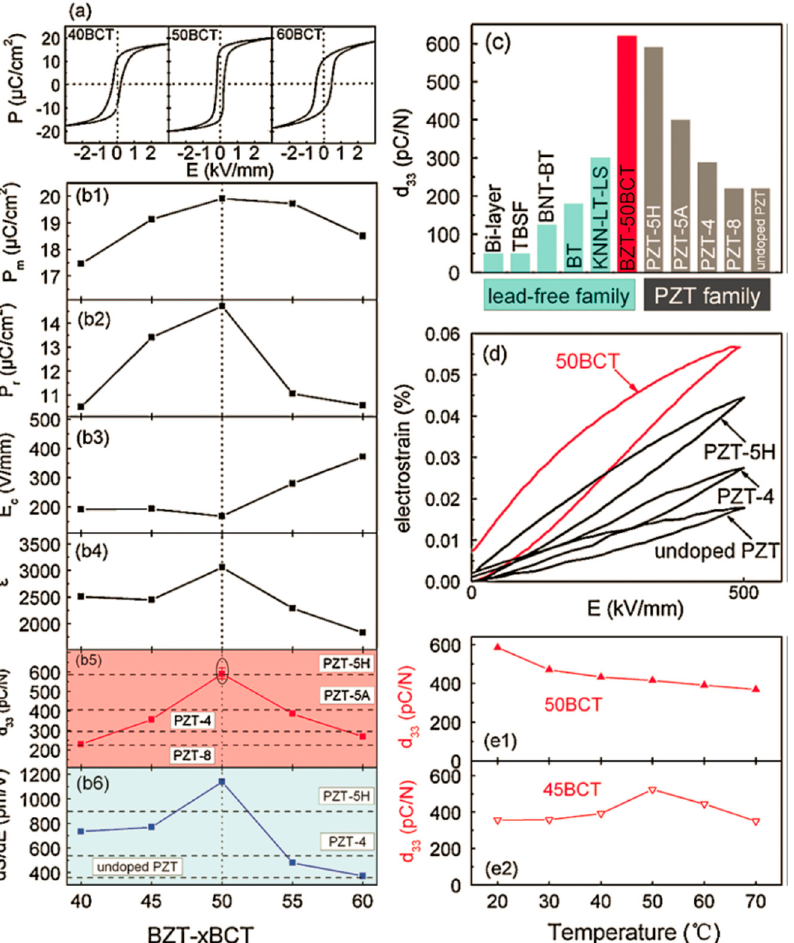
Figure 9. The composition dependence of the piezoelectric, dielectric, and ferroelectric properties for BZT–BCT piezoelectric system [14]. ( a ) P-E hysteresis loop. ( b1 – b6 ) Maximum polarization, remnant polarization, coercive field, dielectric permittivity, d 31 , d S /d E . ( c , d ) The comparison for the piezoelectric parameters between BZT–BCT and other systems. ( e1 , e2 ) The temperature stability for BZT–BCT.